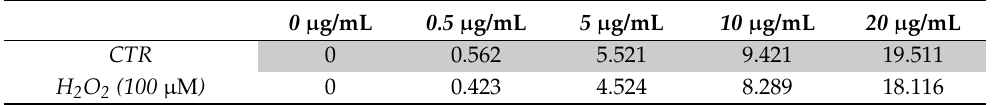
Table 1. Total polyphenol content in supernatants of cultured